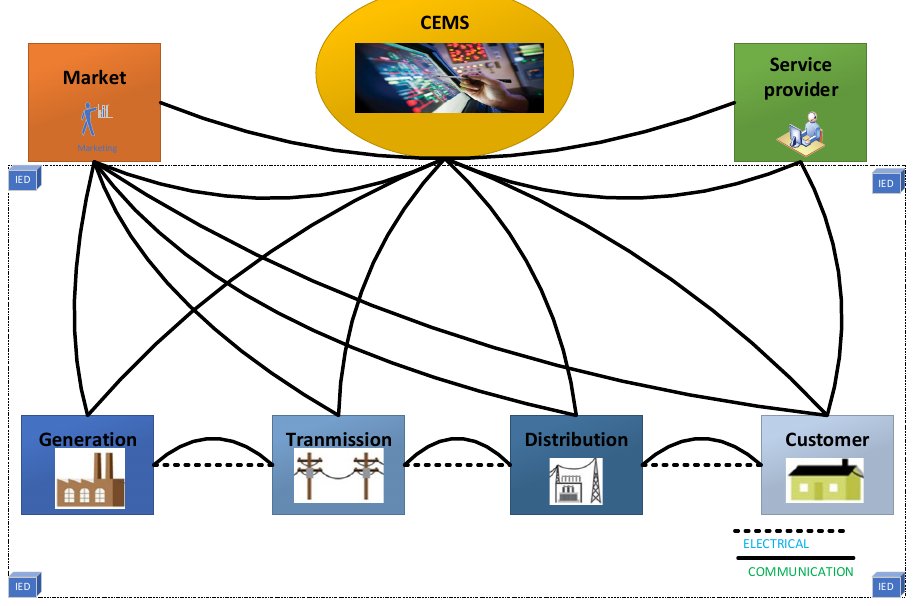
Figure 1. A schematic of an IED based smart grid.